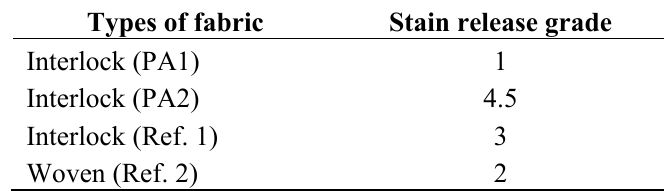
Table 1. Stain release grades according to AATCC test method